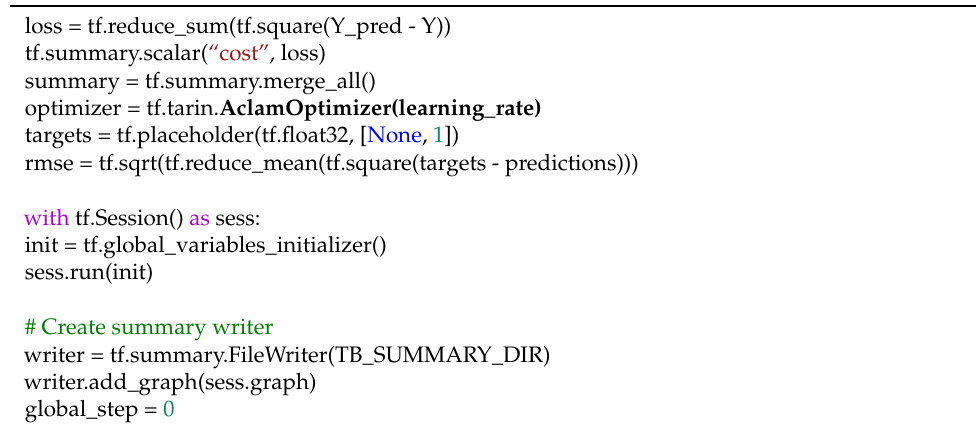
Table 6. Code of the cost minimization process for the training model.